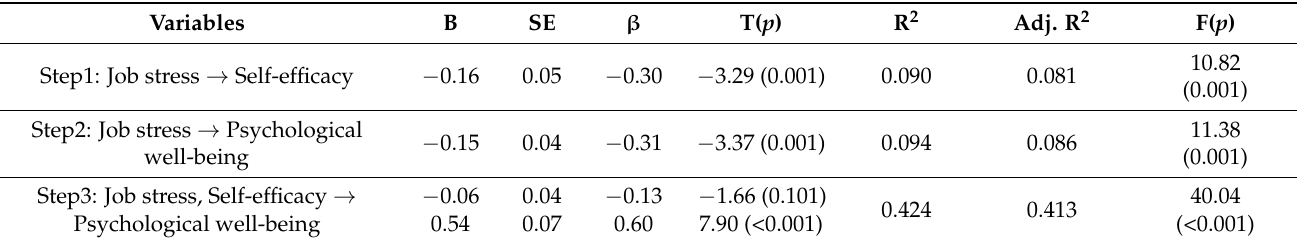
Table 3. Mediating effects of self-efficacy in the relation between job stress and psychological well- being in